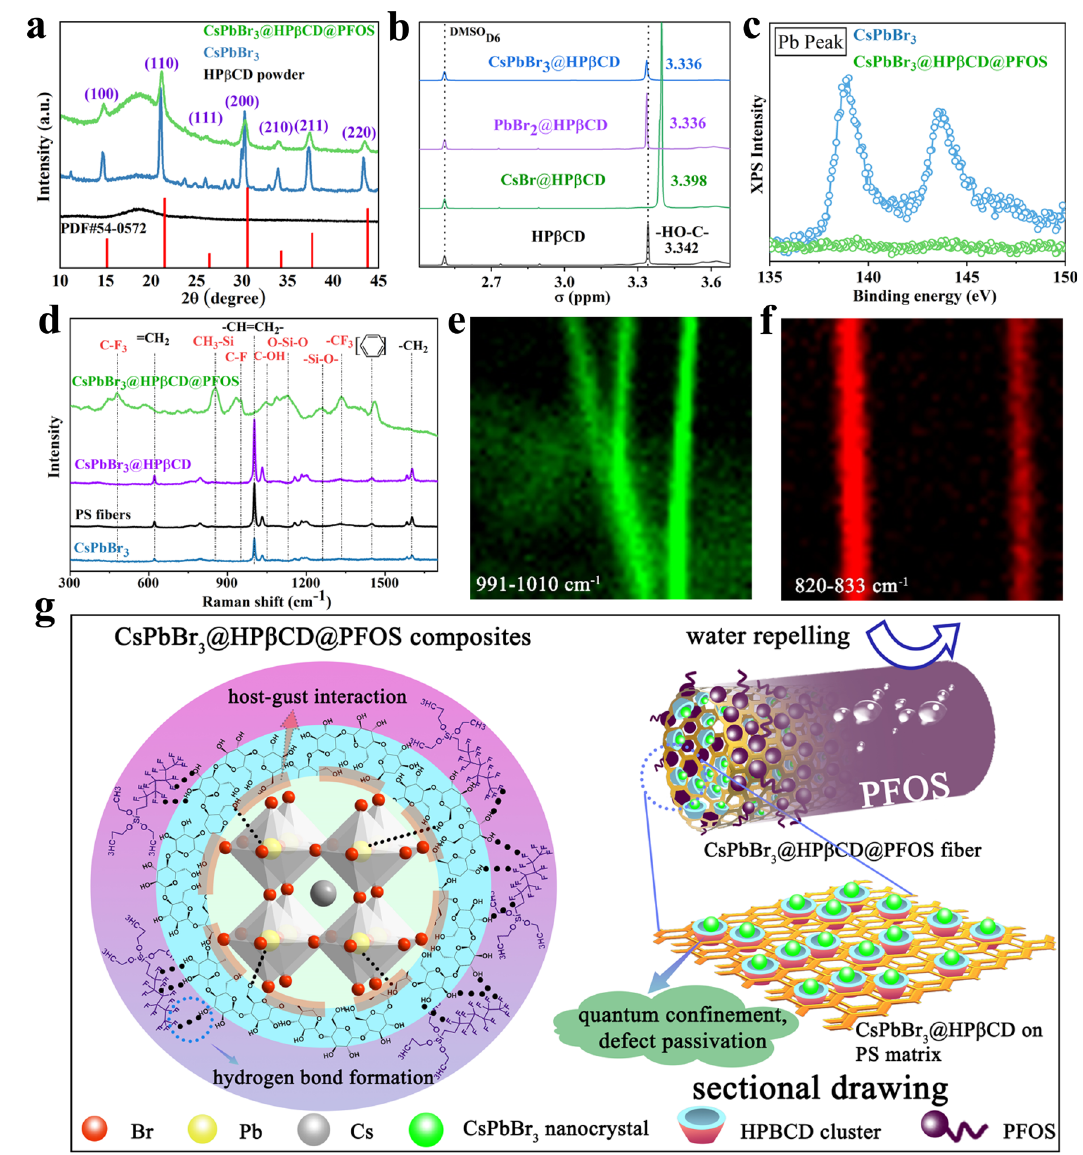
Fig.2|Chemicalinteraction,bondingformationandmultifacetedfunctionsof PLTs.a XRD patterns of HP β CD power, CsPbBr 3 fi bers and CsPbBr 3 @HP β CD@PFOS